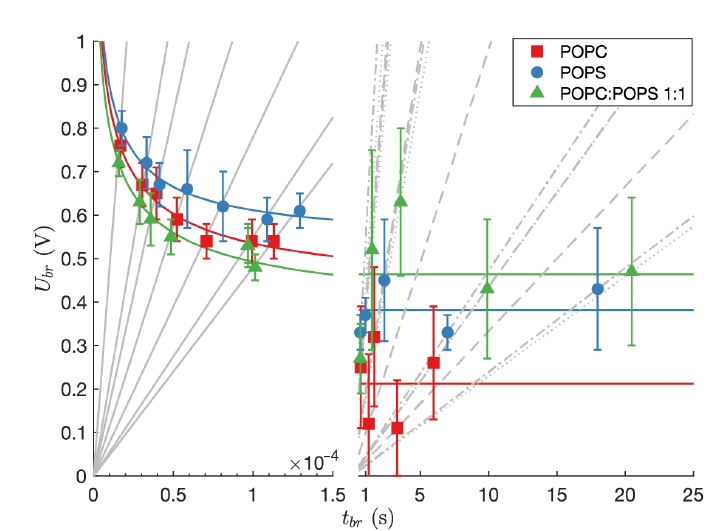
Figure 2. Breakdown voltages of specific lipid compositions measured during voltage-controlled ( left side) and current-controlled ( right side) experiments. The gray lines show different slopes ( k u — left side, k i — right side) of linearly rising signal. Colored curves ( left side) represent two-parameter strength-duration curves (Equation (2)) fitted to the data obtained by voltage-controlled measure- ments on POPS, POPC, and POPC:POPS mixture, respectively. Colored lines ( right side) represent the average values of measured U brI for POPC, POPS, and POPC:POPS mixture,